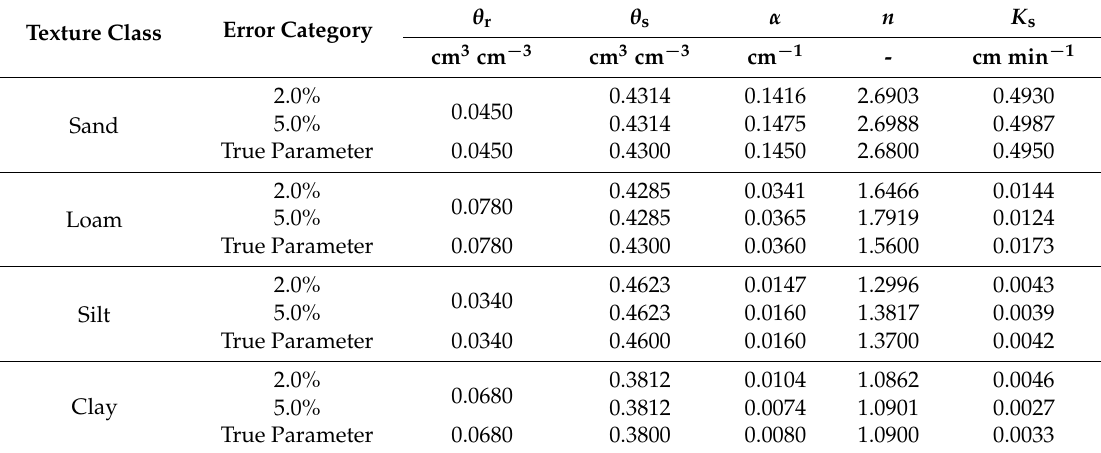
Table 7. Estimated parameters considering random errors on cumulative infiltration for the four typical